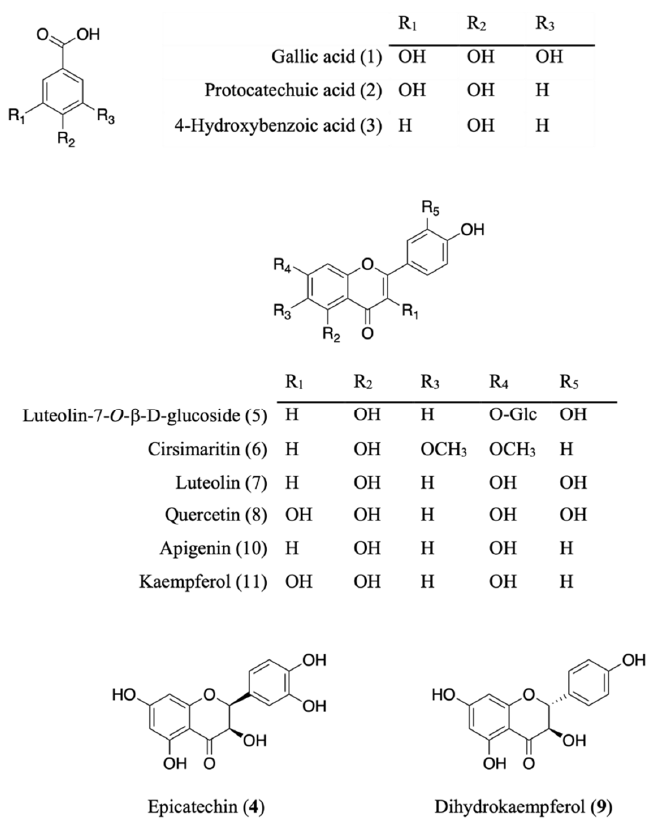
Figure 1. Chemical structures of isolated and/or standard compounds from AE.